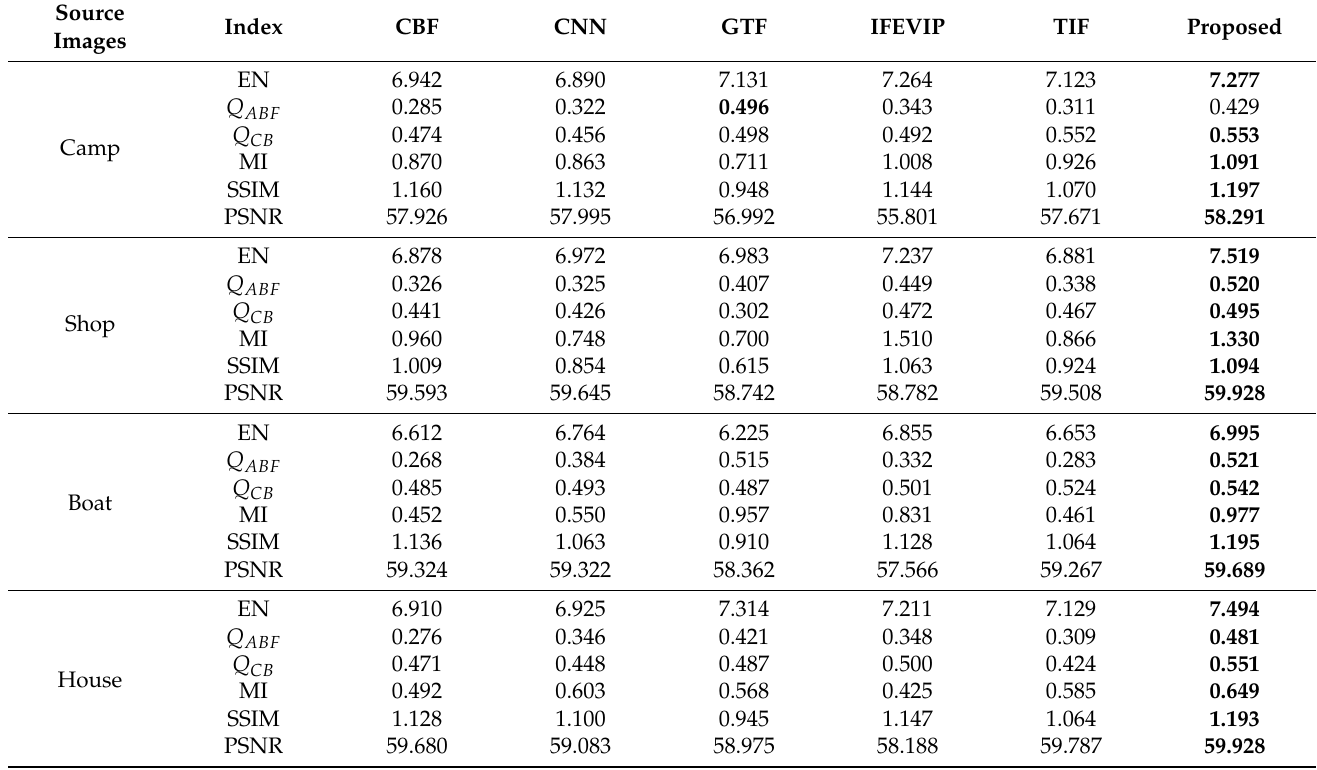
Table 2. Quantitative index of image fusion results ( σ = 20